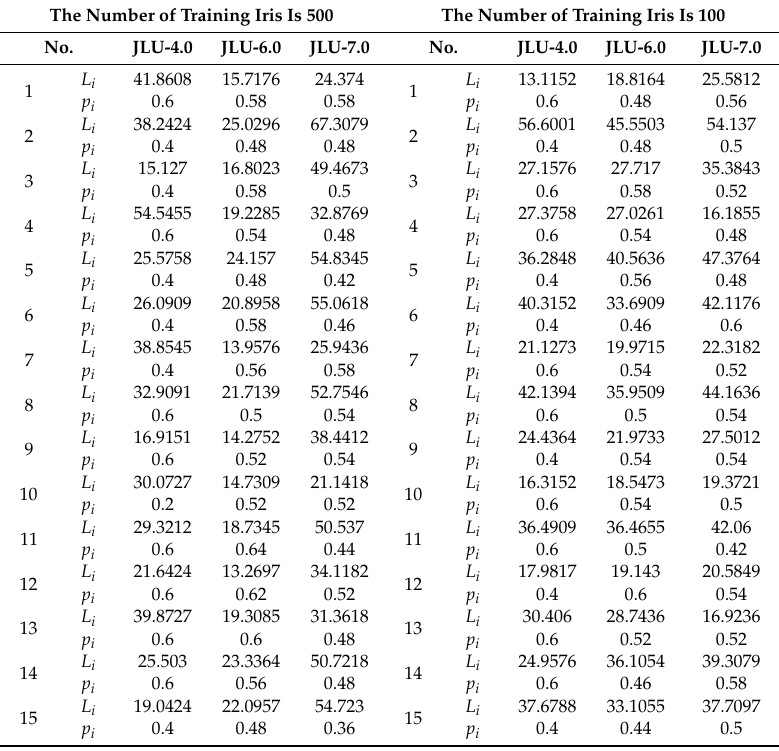
Table 7. L i And p i of 15 recognition parameters of 500 training images and 100 training images.